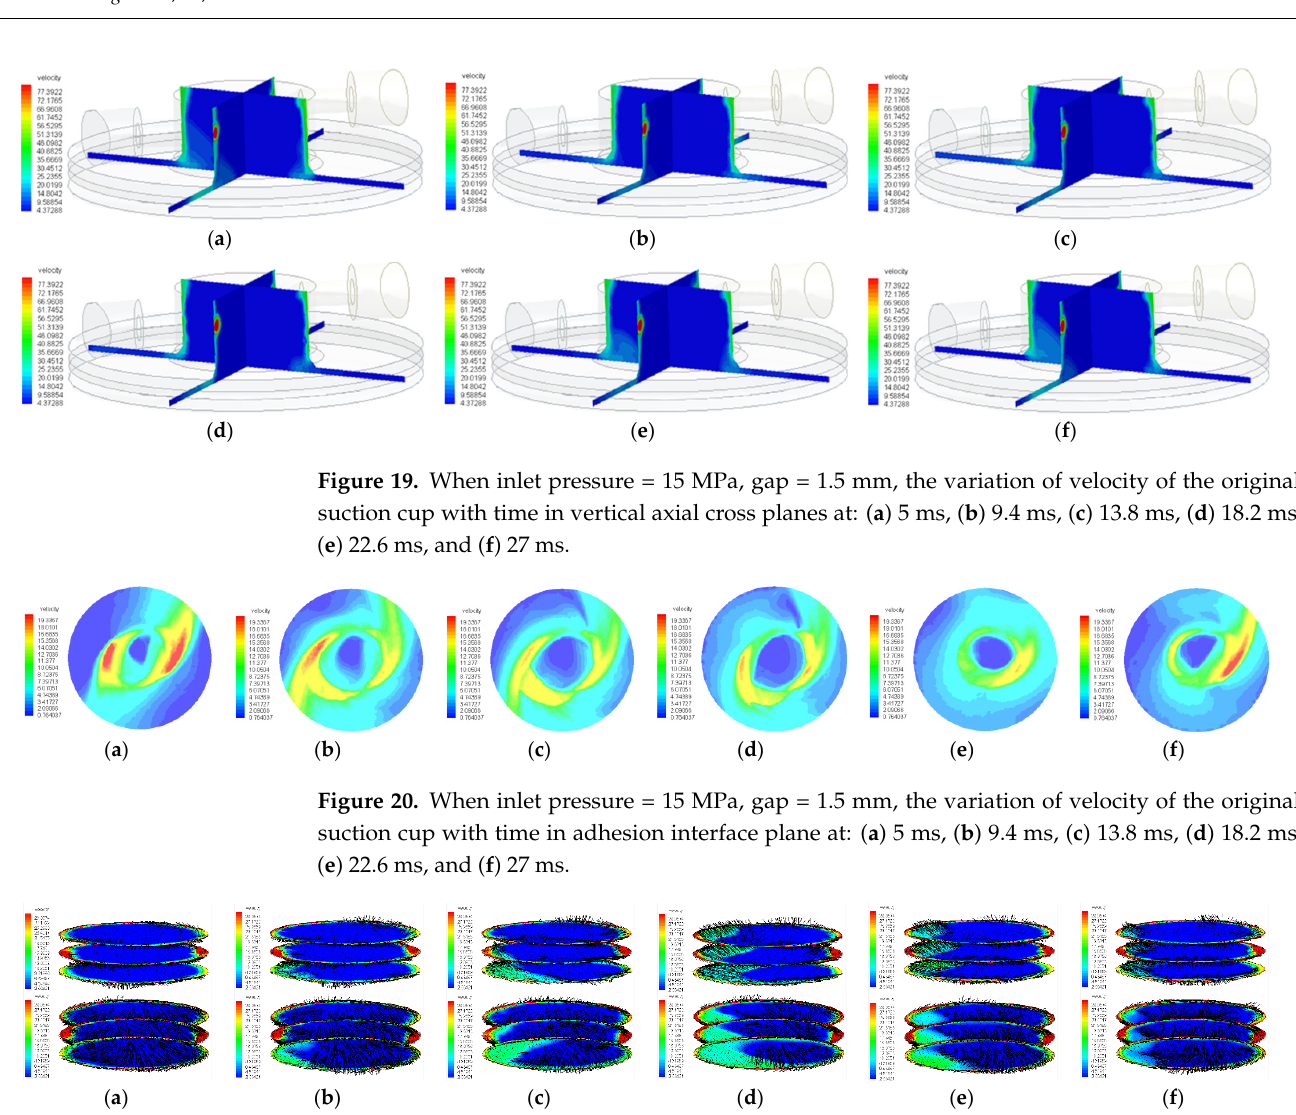
Figure 18. When inlet pressure = 15 MPa, gap = 1.5 mm, the variation of cavitation number of the